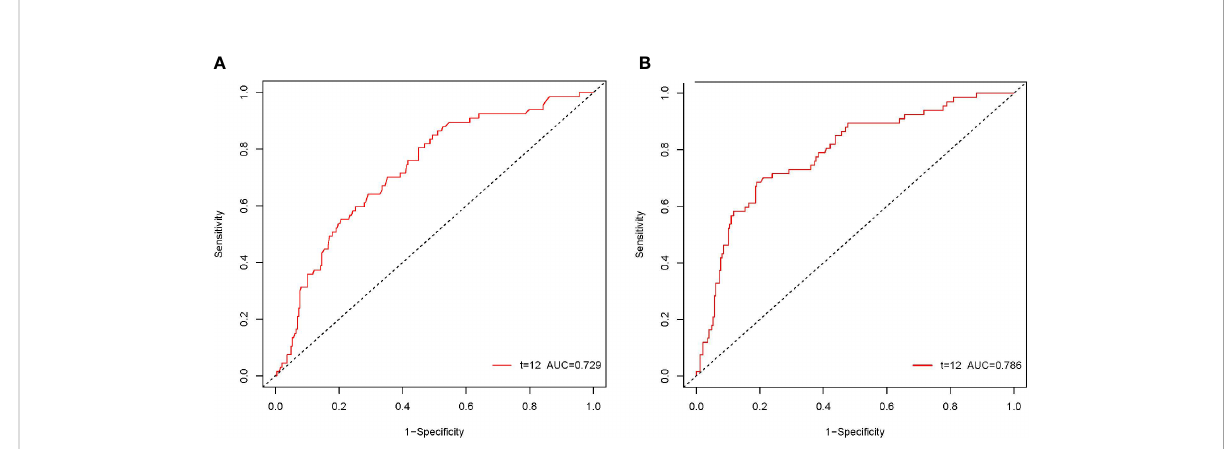
FIGURE 2 The ROC curves of the NLR and PLR in patients with pCCA. The ROC area of NLR was 0.729 (A) . The ROC area of PLR was 0.786 (B) .